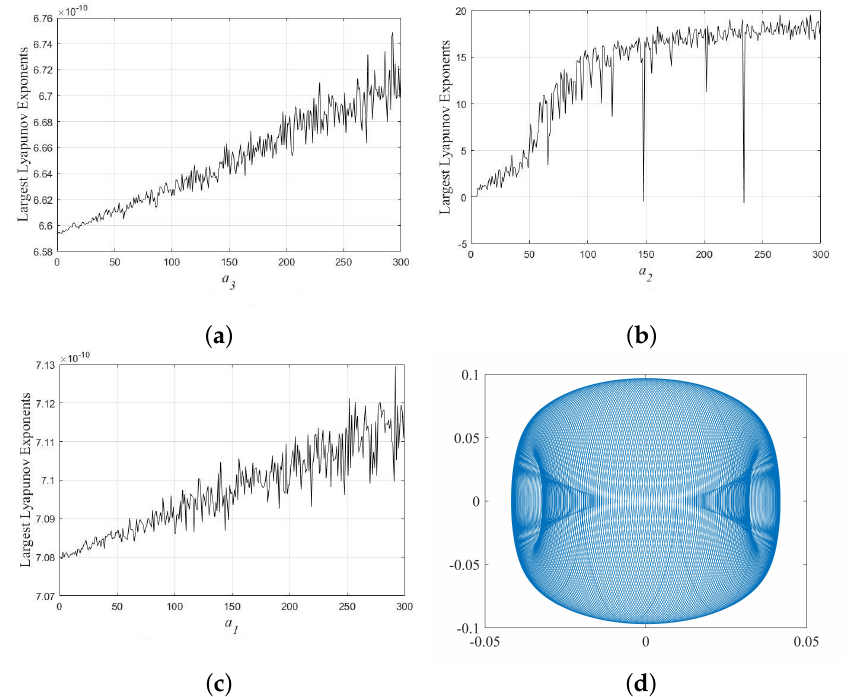
Figure 3. System (7): ( a ) Largest Lyapunov Exponents for a 3 ; ( b ) Largest Lyapunov Exponents for a 1 ; ( c ) Largest Lyapunov Exponents for a 2 ; ( d ) Phase portrait, when a 1 = − 0.9184, a 2 = − 0.2232, a 3 = − 1.7149, R ( ξ ) = sin ( 10 ξ ) .